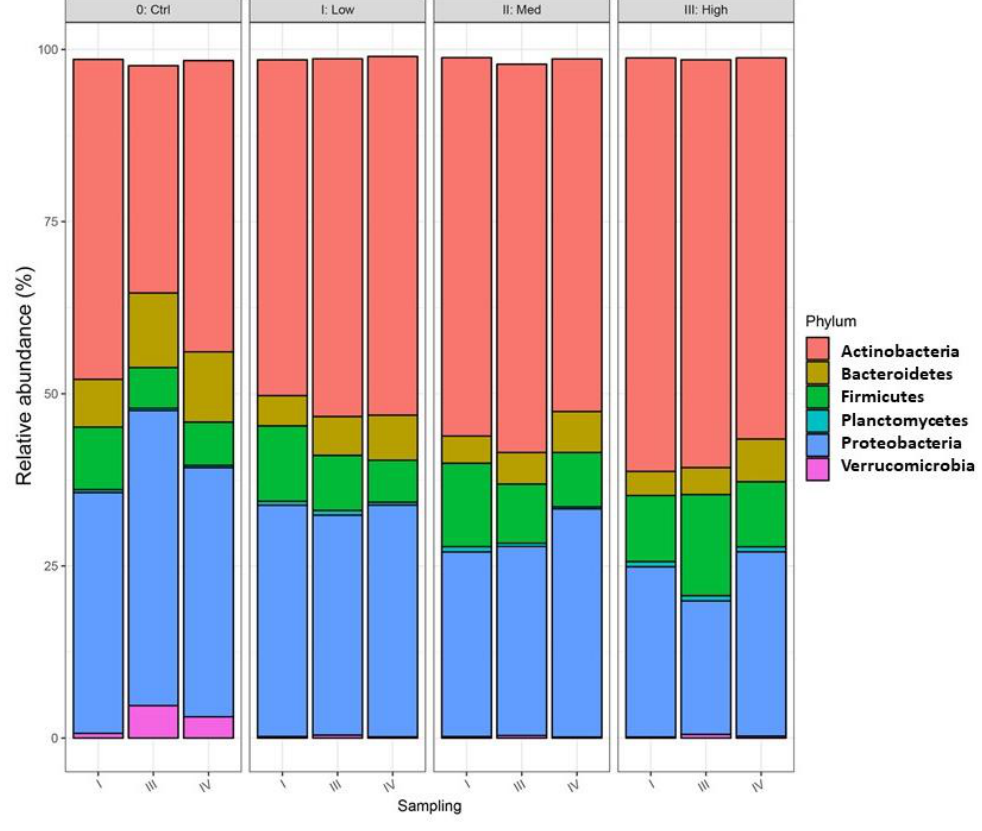
Figure 5. Most abundant phyla in loamy soil as a result of water stress. Ctrl, Low, Med,